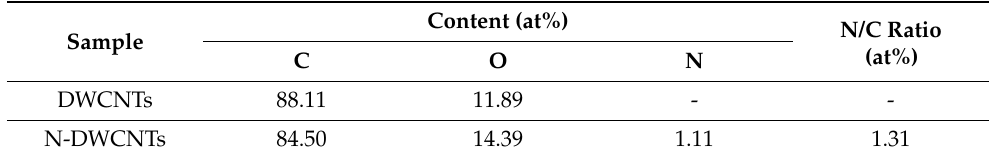
Figure 3. ( a ) XPS survey spectra of the DWCNTs and N-DWCNTs. ( b ) N 1s spectrum and peak fitting of the N-DWCNTs. Table 1. The C 1s, O 1s and N 1s composition of DWCNTs and